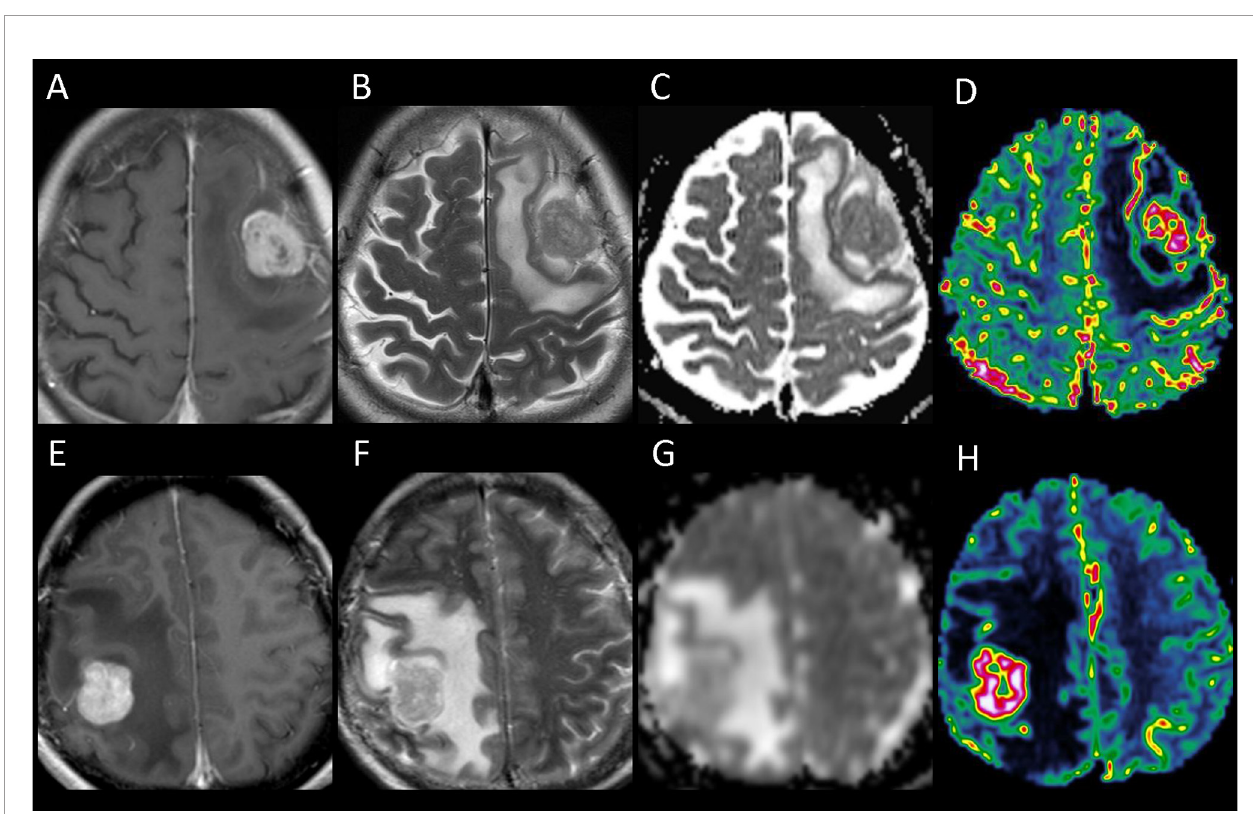
ADC, apparent diffusion coef fi cient; ALPS, analysis along the perivascular space; CBV, cerebral blood volume; FA, fractional anisotropy; SD, standard deviation; B, unstandardized coef fi cient; b , standardized coef fi cient; SE, standard